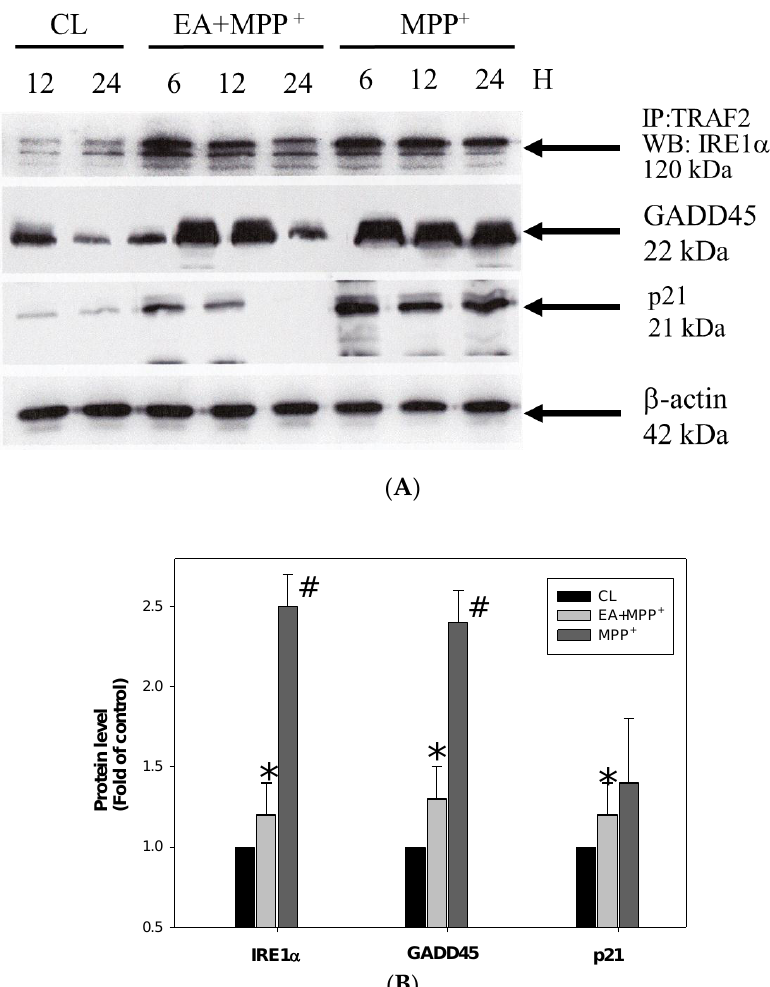
Figure 3. Erinacine A reduced MMP + and increased the interaction of TRAF2 and IRE1, as well as expression of GADD45. ( A ) After the cells were treated with 0.1% DMSO, MPP + , or MPP + and erinacine A for 24 h, immunoprecipitation and immunoblotting analyses were performed to detect the interaction of TRAF2 and IRE1 and the expression of GADD45, respectively. β -actin served as the internal control. ( B ) Quantification of the immunostaining for TRAF2, IRE1, and GADD45 at 24 h by densitometric analysis from three independent experiments; the data were normalized to that of β -actin and expressed as the fold increase of the untreated control. Two independent experiments were performed in duplicate; * p < 0.01, as compared to the control group; # p < 0.01, as compared to the MPP + -treated